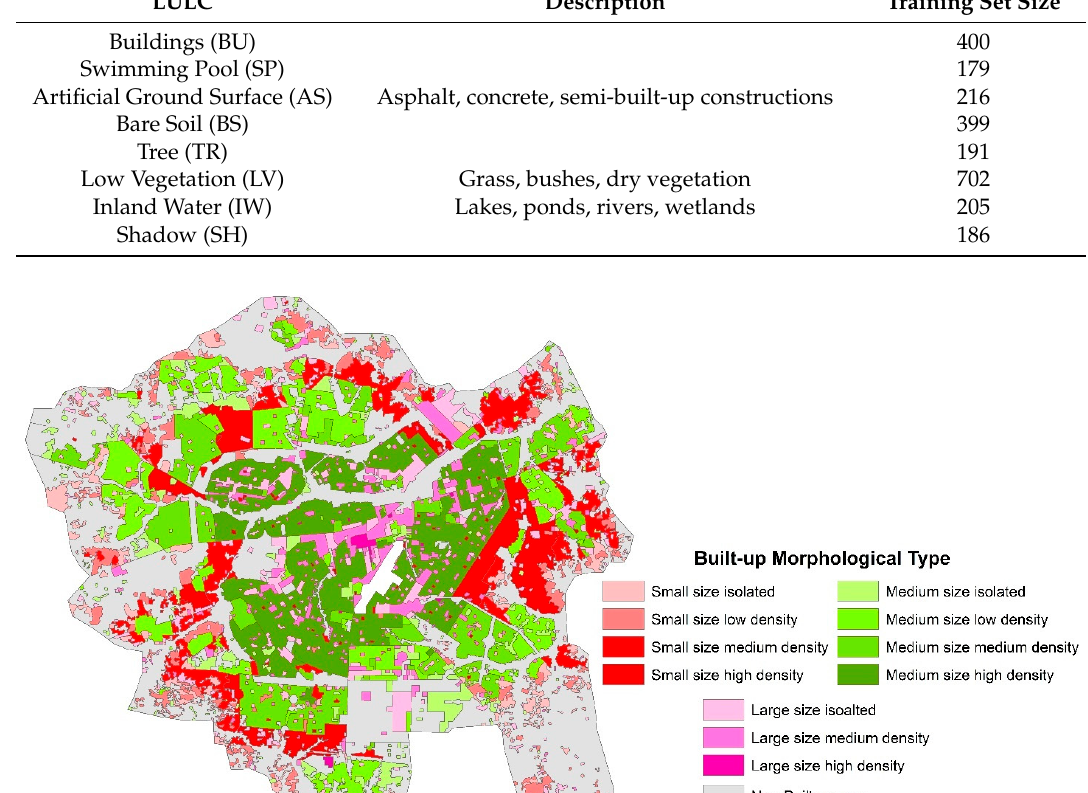
Table 1. Training objects for each LULC class and method.